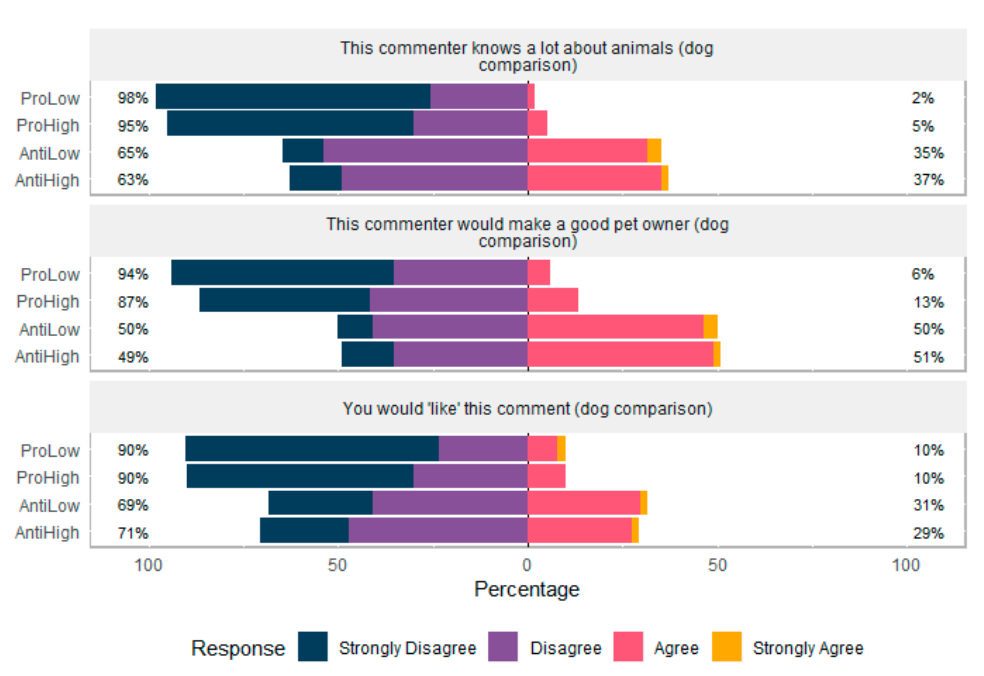
Figure 4. Participants’ (N = 211) agreement with commenter statements comparing primates to domesticated dogs.